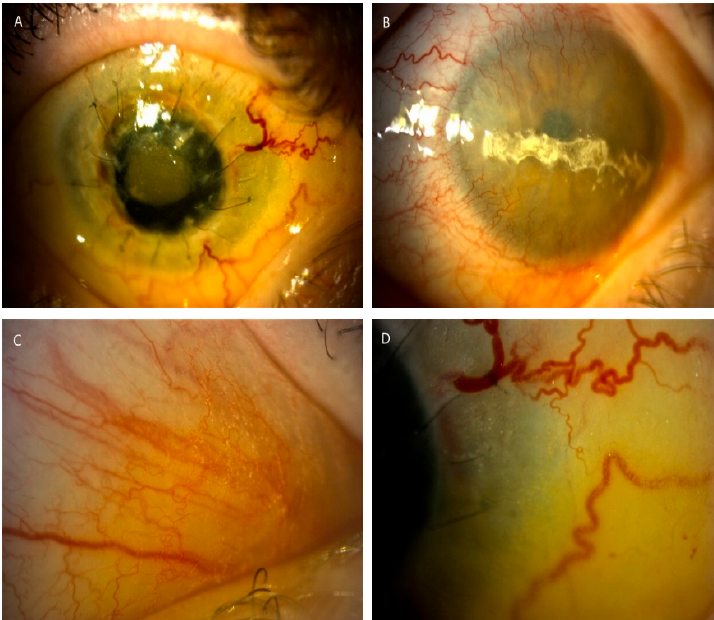
Figure 3. Slit-lamp photographs (10–25 × ) displayed complications of the anterior segment in long-term nephropathic cystinosis with delayed treatment (patient 6). ( A ) Cornea after two unsuccessful keratoplasties with hazy transplant, ingrown vessels, loose sutures and hyperemia of conjunctiva in the right eye. ( B ) Band keratopathy and significant peripheral corneal neovascularization in the left eye. ( C , D ) Significant density of crystal deposits in conjunctiva, in places blurring the drawing of the vessels.